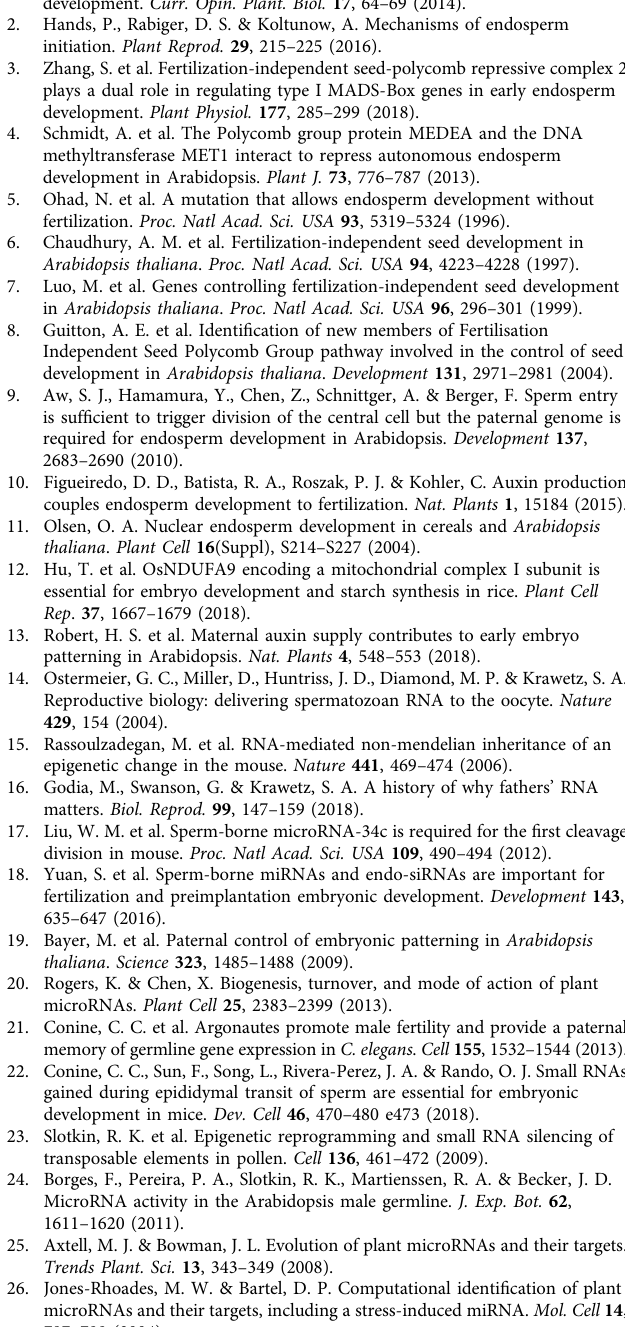
5 ′ RACE-PCR experiments . For the detection of 3 ′ cleavage products from miR159-targeted MYB33 and MYB65 , 5 ′ RACE was performed using the Gen- eRacer kit (Invitrogen). Flowers at stage 12 from Col-0 were emasculated and naked pistils were left to grow for ~12h for maturation. Then naked pistils were hand-pollinated with pollen grains of Col-0 or the mir159abc mutant. For detecting the cleavage products of mMYB33-GFP transcripts, the naked pistils from proFWA::mMYB33-GFP transgenic plants were hand-pollinated with pollen grains of Col-0. The developing seeds from dissected siliques indicated time points were collected in liquid nitrogen immediately, and total RNA was extracted with Trizol reagent. A total of 1 – 5µg total RNA was directly ligated with the GeneRacer RNA oligo nucleotide and reverse transcription reactions were carried out with gene-speci fi c primers listed in Supplementary Table 3. Semi-quantitative PCR reactions were performed to quantify 3 ′ cleavage products and full length tran- scripts, respectively. The PCR reactions were performed as regular conditions: 95 ℃ 30 s, 58 ℃ 30s, 72 ℃ 1min, 32 cycles. The same amount of RNA was reversely transcribed with oligo dT to amplify UBQ5 as an internal loading